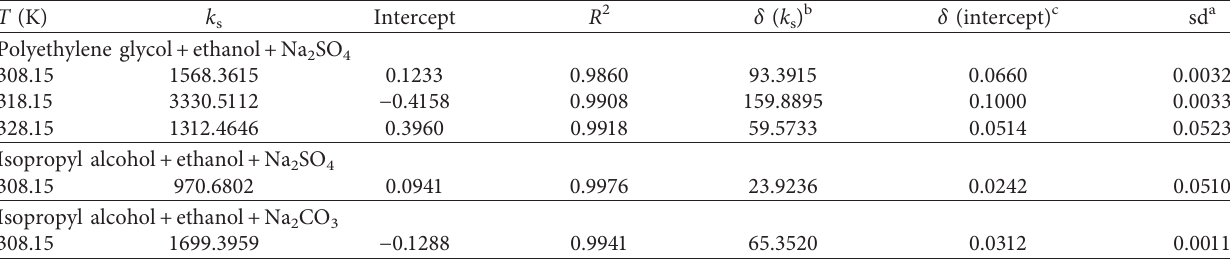
Table 7: Parameters of equation (8) for the mixture of polyethylene glycol/isopropyl alcohol +ethanol +salt (Na ATPSs at different temperatures.